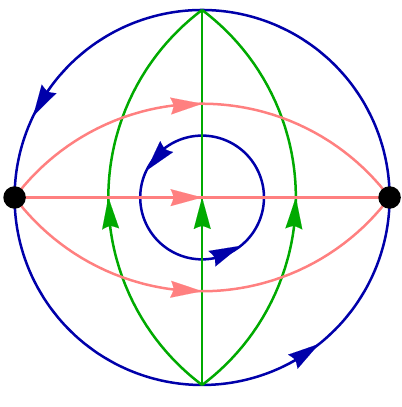
Figure 4 . Geometric action of the generators in Euclidean AdS 2 . Here the charges are inserted at the black points, at ’ = 0 and ’ = (cid:25) . Blue lines follow the boost Killing vectors ~ B ; pink lines, the momentum ~ P ; and green lines, the global energy vectors ~ E